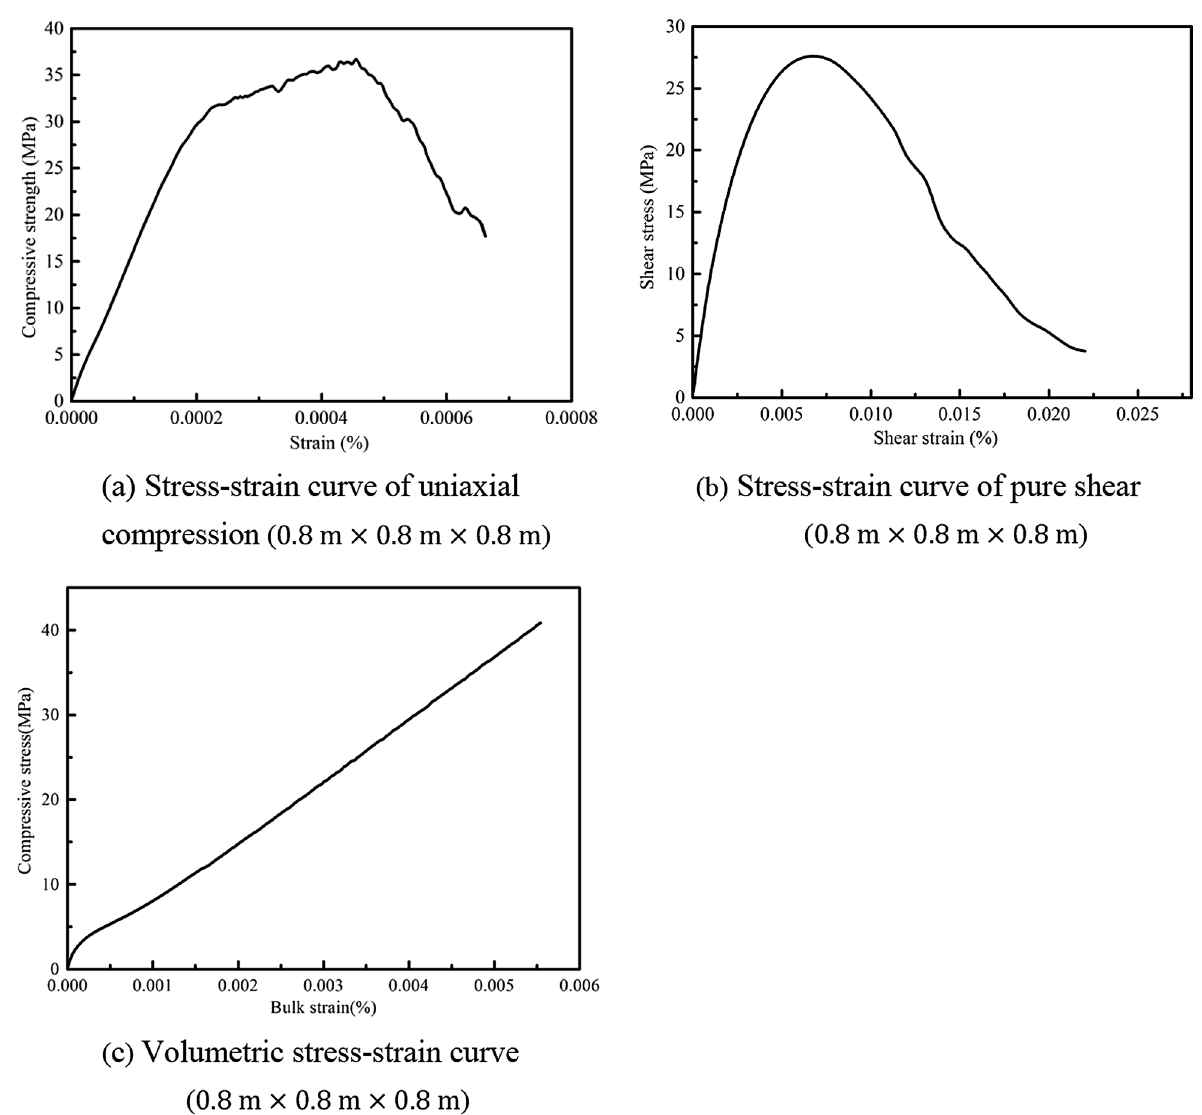
Fig. 9 Stress–strain curve from the discrete element numerical simulation ( K = 1.0, θ =